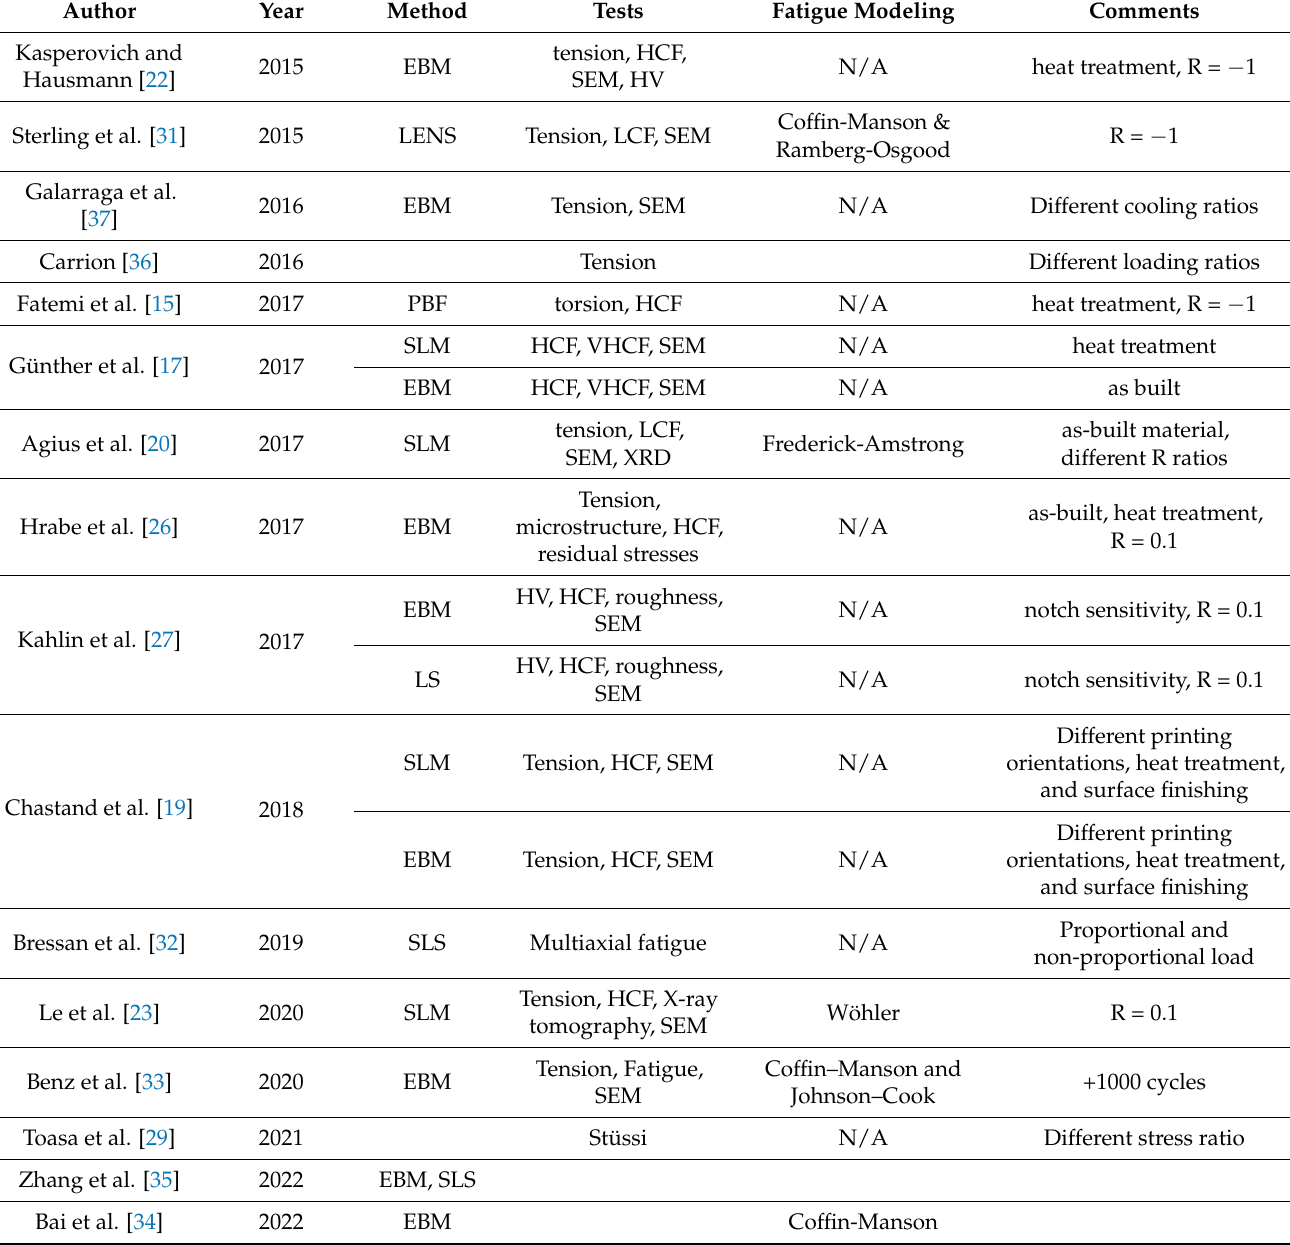
Table 1. Summary of relevant tests for AM Ti–6Al–4V alloys. LCF, low-cycle fatigue; HCF, high cycle fatigue; VHCF, very high cycle fatigue; SEM, scanning electron microscopy; XRD, X-ray diffraction; LS, laser sintering; HV, Vickers